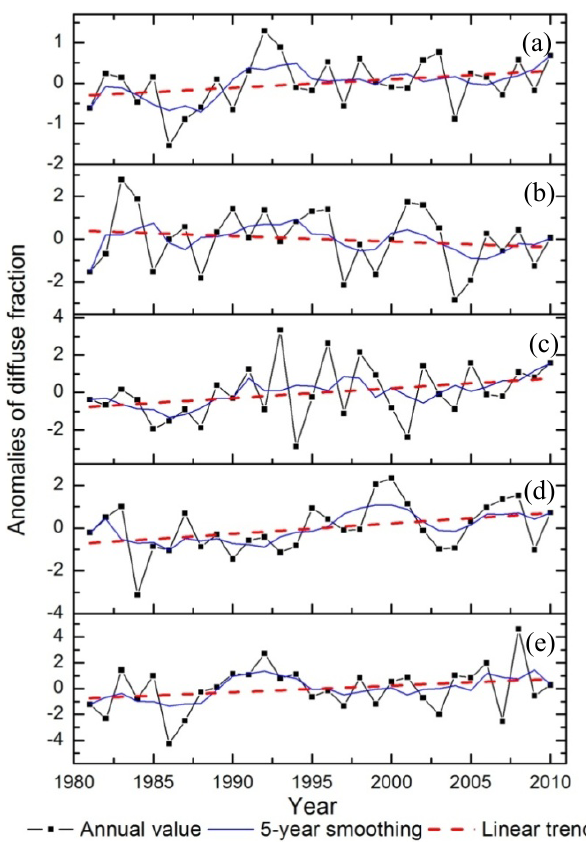
Fig. 10. Anomalies of annual and seasonal diffuse fraction aver- aged all across China from 1981 to 2010 ( a denotes annual diffuse fraction; b , c , d and e denote seasonal diffuse fraction of spring, summer, autumn and winter, respectively. Unit: %). The averages are 47.01, 47.42, 51.10, 42.65 and 43.88, respectively.